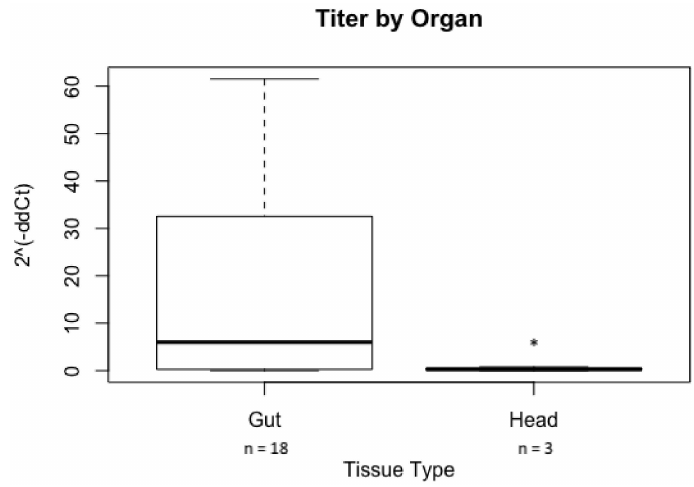
Figure 3. Titer of grapevine red blotch virus (GRBV) in Spissistilus festinus tissue determined by qPCR. Dissected head as well as salivary glands (Head) and gut (Gut) from S. festinus exposed to GRBV-infected Vitis vinifera ‘Cabernet franc’ for two weeks in a California vineyard followed by 48 h on alfalfa were tested. The number of individuals dissected and tested is shown. The error bars indicate the standard error of the mean. The star above the standard error bar indicates significant differences between the ∆∆ Ct expression fold change values (2 − ∆∆ Ct ), as determined by Welch’s t -test ( p <